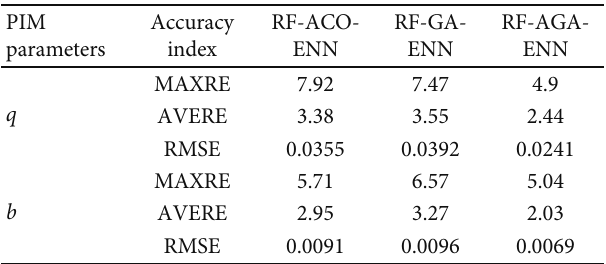
Table 8: Accuracy index values of PIM parameters under di ff erent input layer